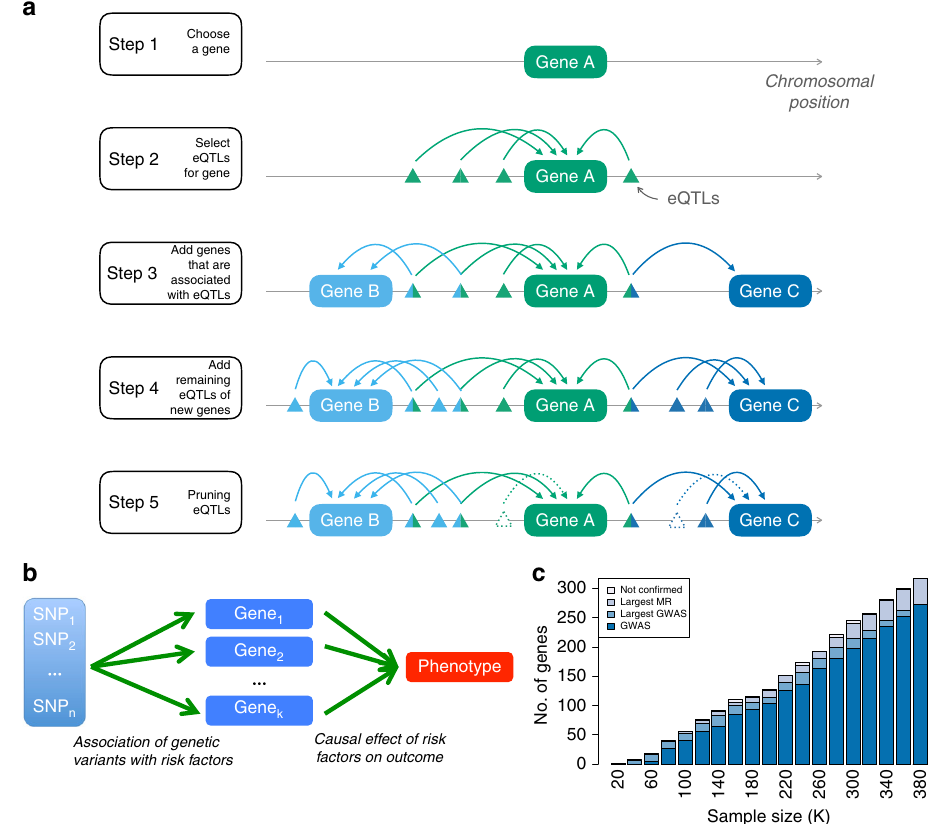
Fig. 1 Overview of TWMR approach. a Work fl ow of the selection of SNPs and genes included in our analyses. For each gene (step 1), we consider all the independent eQTLs with P eQTL < 1.83 × 10 − 5 (step 2) and then we included in the model all the genes for which those SNPs are eQTLs (step 3). In addition, we included in the model all the SNPs that are eQTLs only for these genes (step 4). To avoid multicollinearity issues, we pruned the SNPs keeping only independent SNPs (i.e., r 2 < 0.1) (step 5). b Schematic representation of TWMR to estimate the causal effect of multiple exposures (expression of genes) on a phenotype using multiple instrumental variables (SNPs). c Validation of genes found by TWMR. Bars represent the number of genes found to be causal for BMI when carrying out the TWMR analysis in different sized subsets of the UKBB. Among them, those con fi rmed by GWAS in the same sample (i.e., that fall within 500kb of a GW signi fi cant SNP) are marked in dark blue; those con fi rmed only when running GWAS in the full 380K UKBB samples in light blue; those con fi rmed only running TWMR in the full UKBB data set in gray, whereas the light gray bars on the top represent the number of